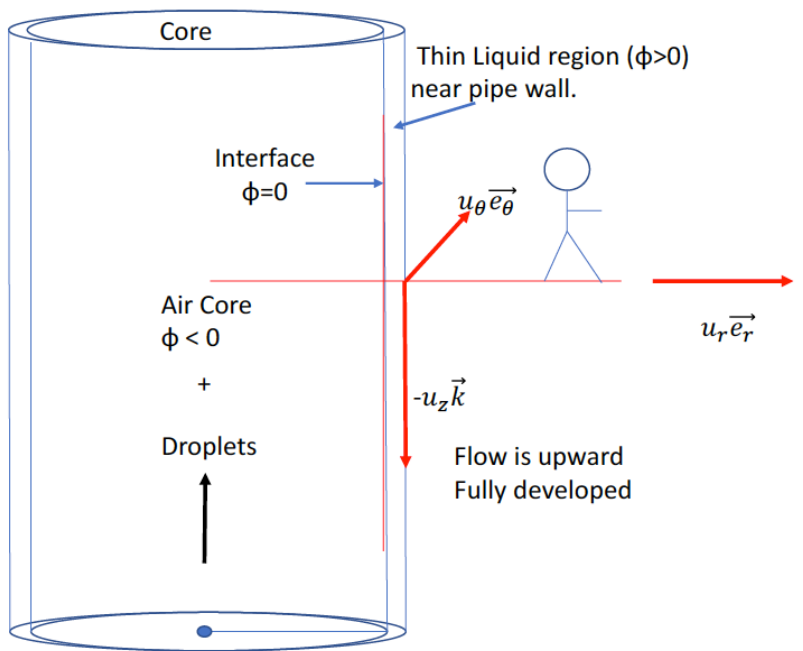
Figure 1. Two Phase Upward Co-current Annular Flow Geometry.